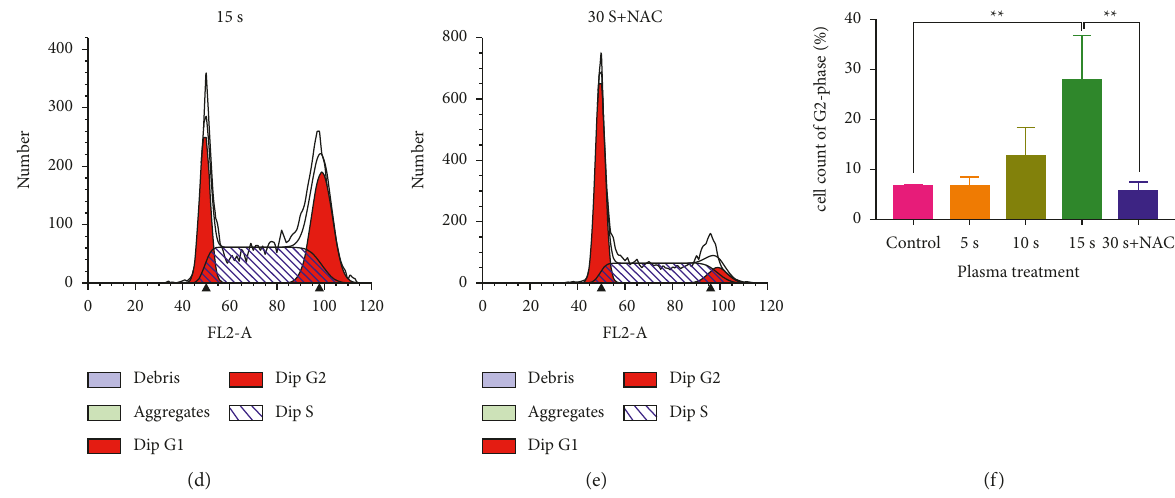
Figure 6: CAP-induced cell cycle arrest of CAL-62 cells in (a) control, (b) 5s CAP-treated cells, (c) 10s CAP-treated cells, (d) 15s CAP- treated cells, and (e) 30s CAP and NAC-treated cells. (f) Cell population in the G2 phase is represented as a percentage of the total cells. Data represent the mean SD of three independent experiments. ±